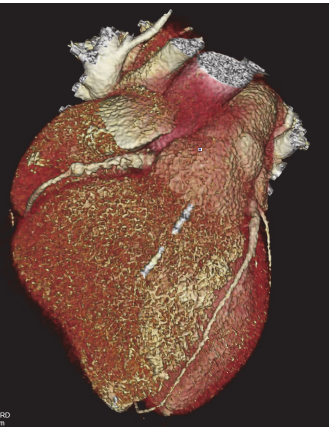
Figure 2: CTA Volume-Rendered Image demonstrating coronary artery